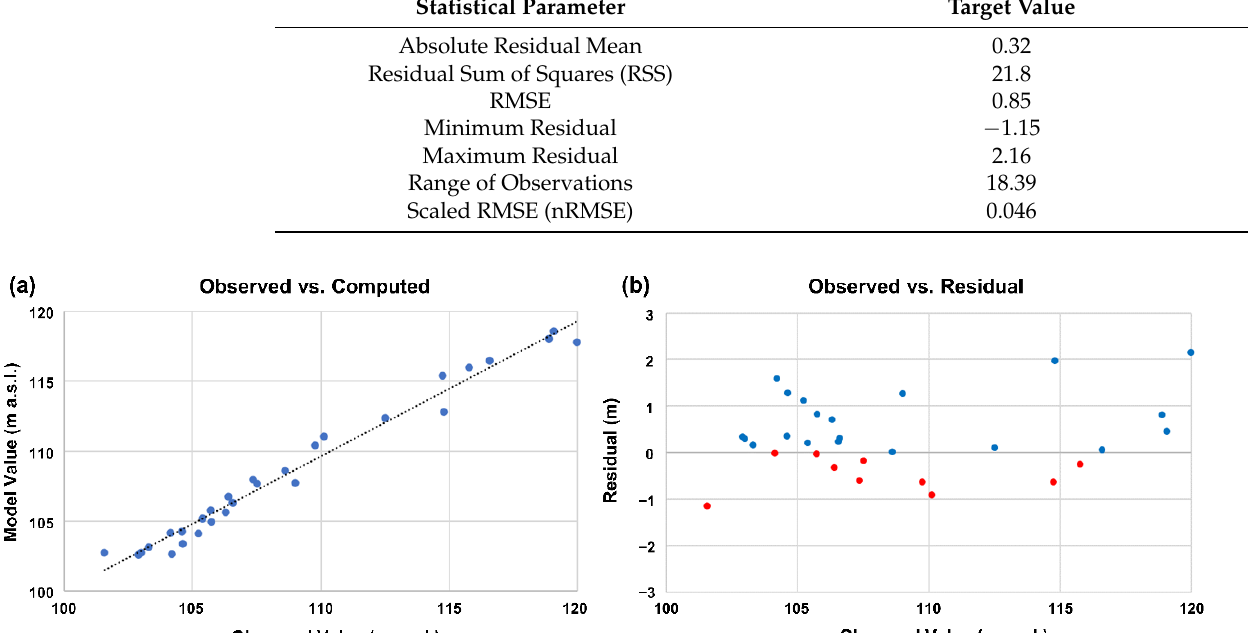
Figure 8. Comparison of ( a ) observed (m a.s.l.) vs. computed (m a.s.l.) values and ( b ) observed val- ues (m a.s.l.) vs. residuals (m).